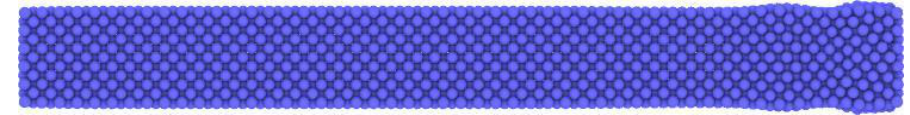
Fig. 16. Outlook of the initially perfect nanorod at the time instant 2 ps after the cyclic loading start.  x 0 = 0.5 Å,  =1 THz.